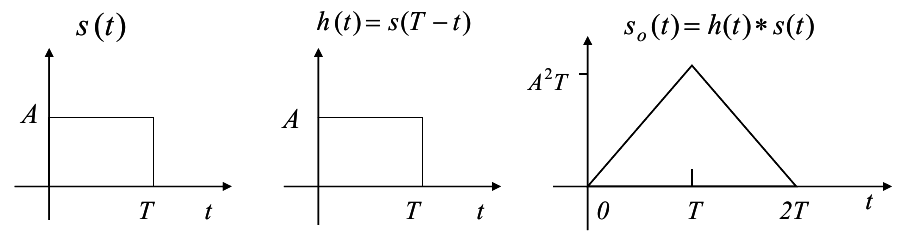
Figure 6 . Matched